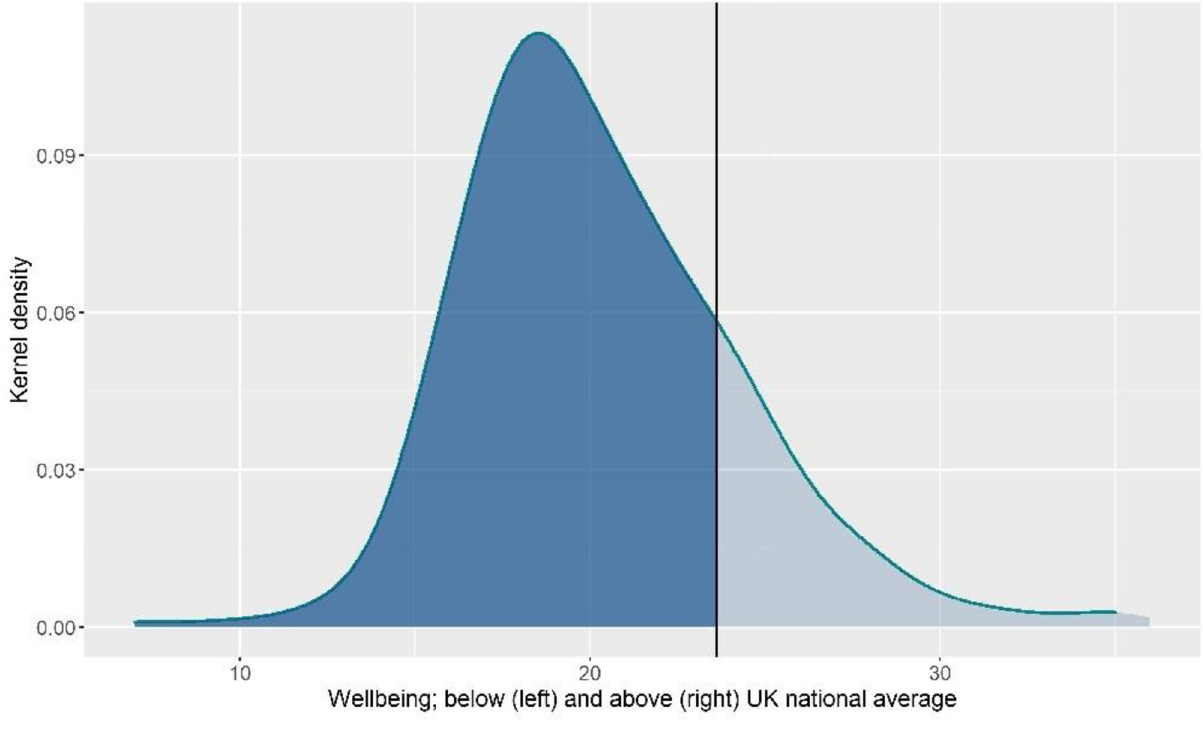
Fig 3. Distribution of